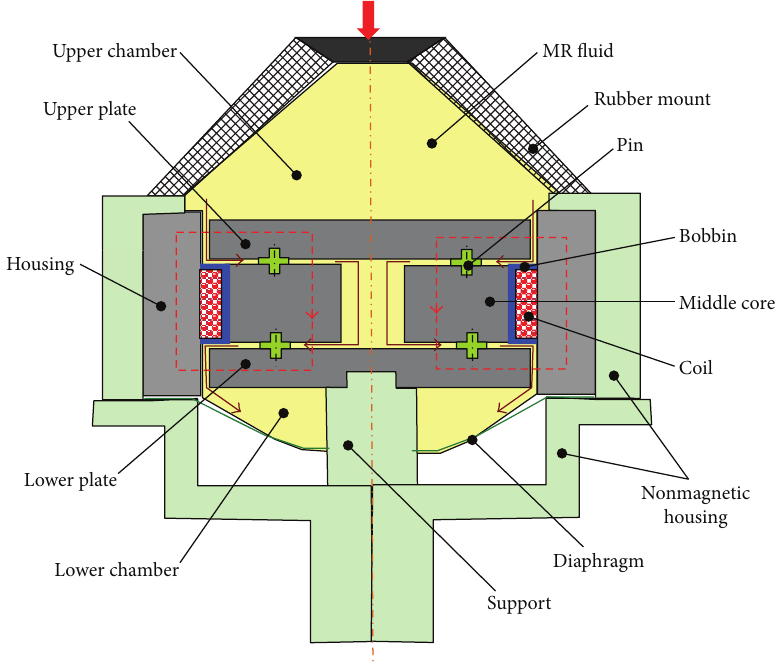
Figure 5: Configuration of high loaded MR mount with fixed middle